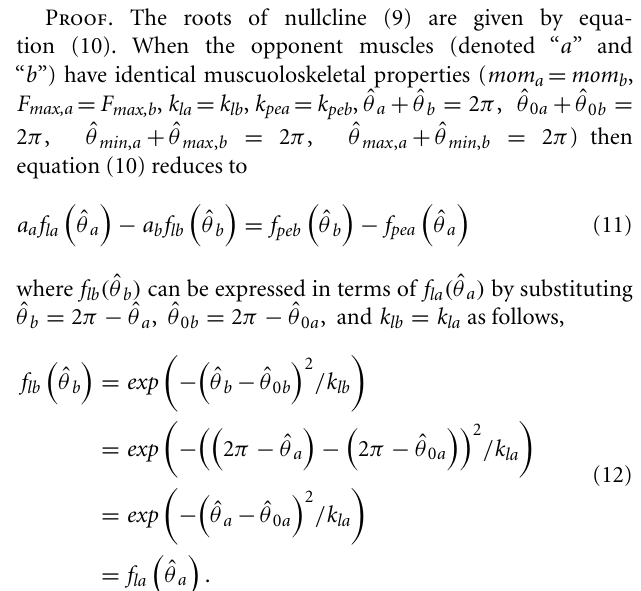
of balanced co-contraction when the CE resting length parameter is manipulated between θ 0 = θ a0 = θ b0 = 0 (the limit of joint flexion) and θ = θ = θ = π (the midpoint of muscle). Point A ( θ = 3.00, a = 1) marks the 0 a0 b0 0 emergence of bistability at 100% co-contraction levels. Point B ( θ 0 = 2.86, a = 0.5) marks the emergence of bistability at 50% co-contraction levels. Point C ( θ 0 = π − 1, a = 0.171) corresponds to point CP in the previous panel. Point D ( θ 0 = 1.68, a = 0.154) marks the maximal extent of the bistable